Question: Briefly state, in one sentence, what is plotted here.
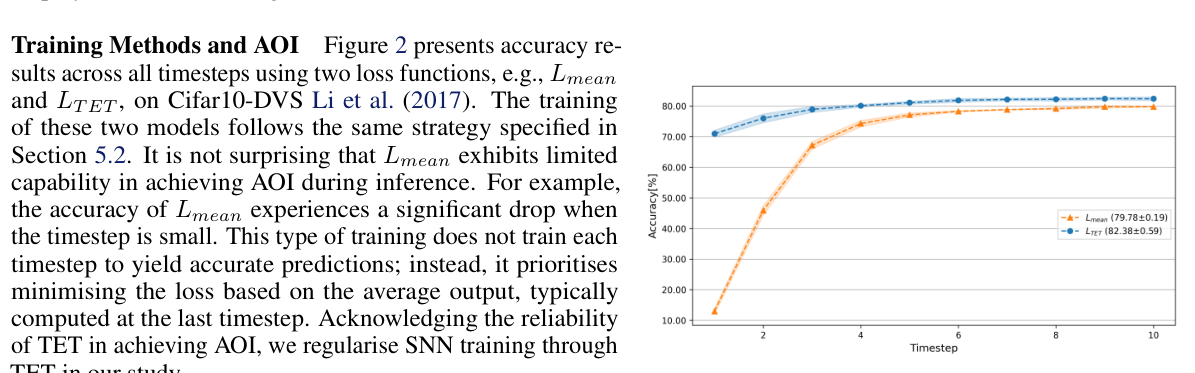
Answer: Comparison of accuracy with respect to timestep using different loss functions on Cifar10-DVS.